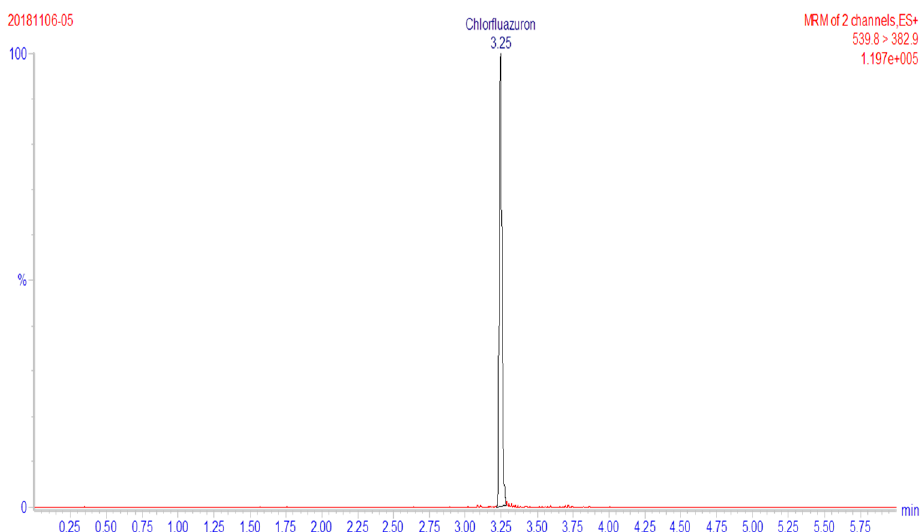
Figure 1. Chromatogram of chlorfluazuron.